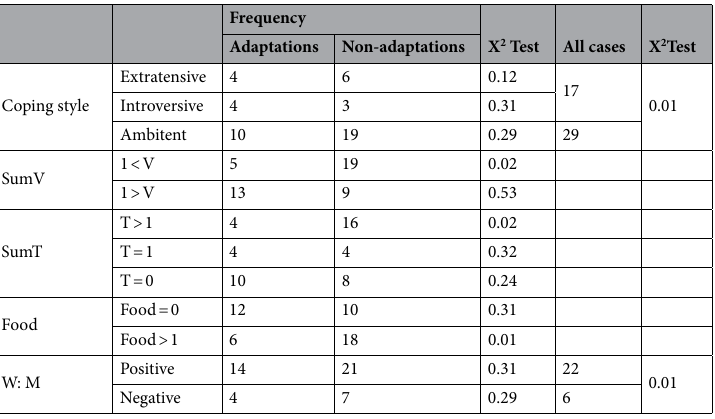
Table 8. Χ 2 test for coping style, SumV, SumT, food, W:M.